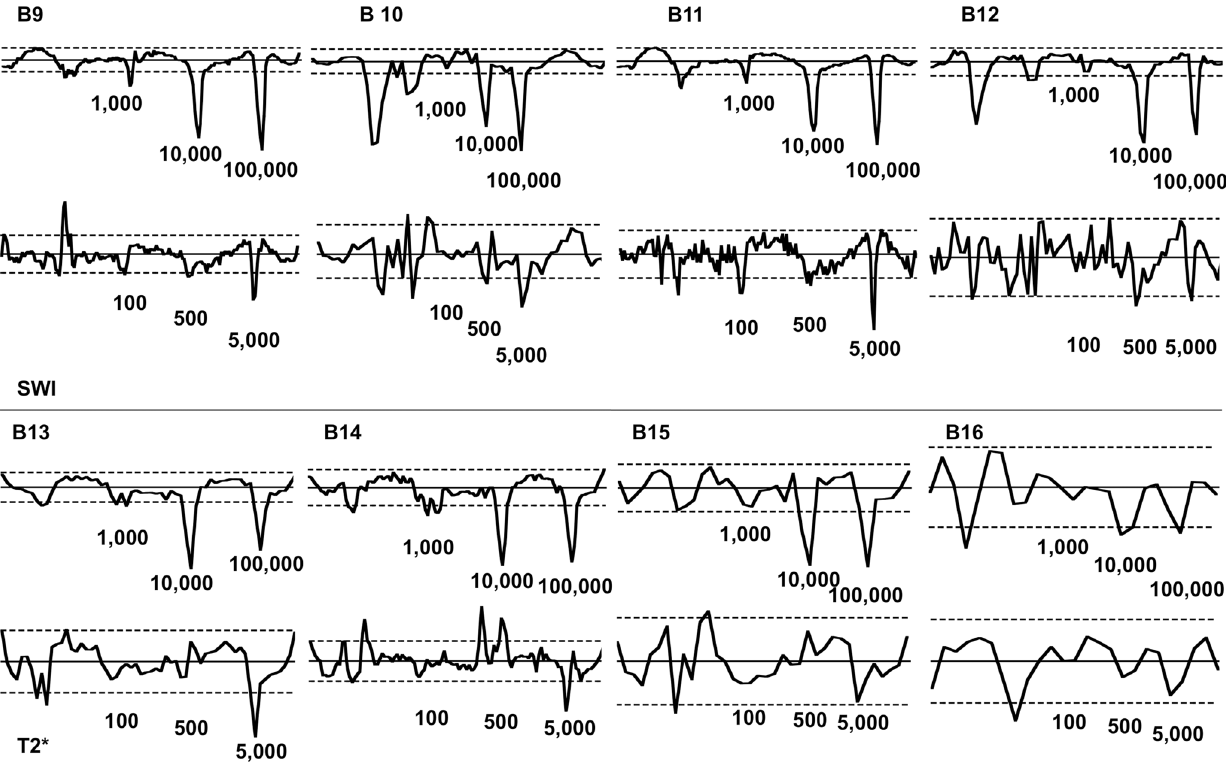
Figure 8. Results of the ROI based evaluation of examinations with the 8 channel coil. As in Figure 7 results obtained by using SWI (phantoms B9 to B12) and T2* (phantoms B13 to B16) sequences are listed separately. The form of the graphs is the same as in figure 7. Again sequences with a lower slice thickness (i.e. better resolution of data points) depict the signal loss due to labeled MSC better than sequences with a greater slice thickness (i.e. B11 vs. B16). With the knee coil, significant peaks at layers containing 500 labeled MSC could be identified (i.e. B9, see also table 2).